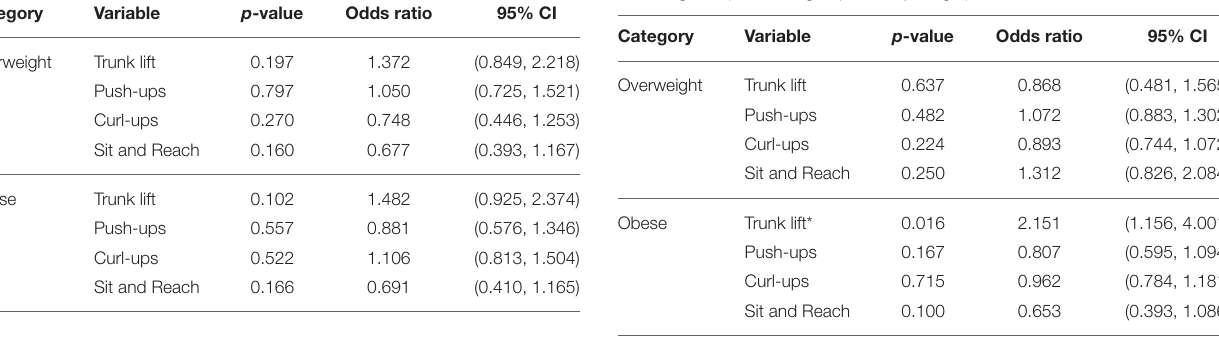
TABLE 2B | Associations between musculoskeletal fitness and weight status in kindergarten (reference group: obese). Category Overweight